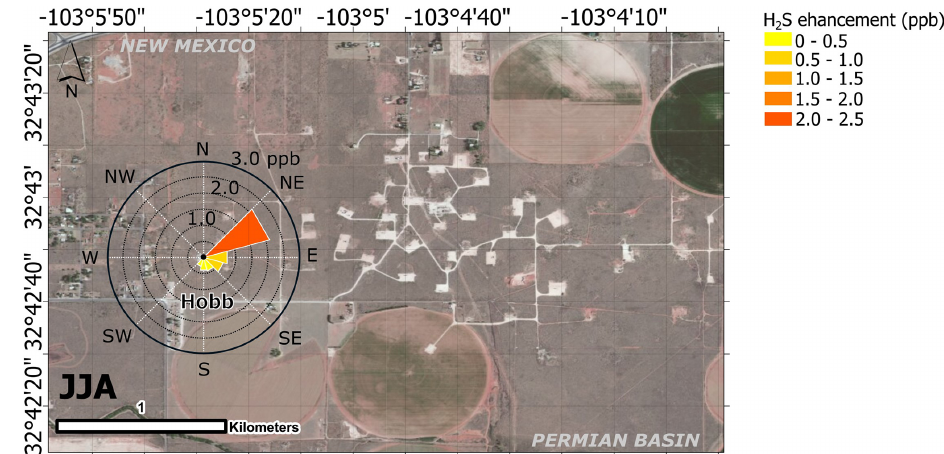
Figure 10. Hydrogen sulfide enhancements at the Hobbs tower, at 91ma . g . l . , during summer months, i.e., June, July, August (JJA). The “triangles” represent the mean of the afternoon (20:00–23:00 UTC) enhancements coming from the indicated direction. Credits for base map: Esri, DigitalGlobe, GeoEye, Earthstar Geographics, CNES/Airbus DS, USDA, USGS, AeroGRID, IGN, and the GIS User Community.